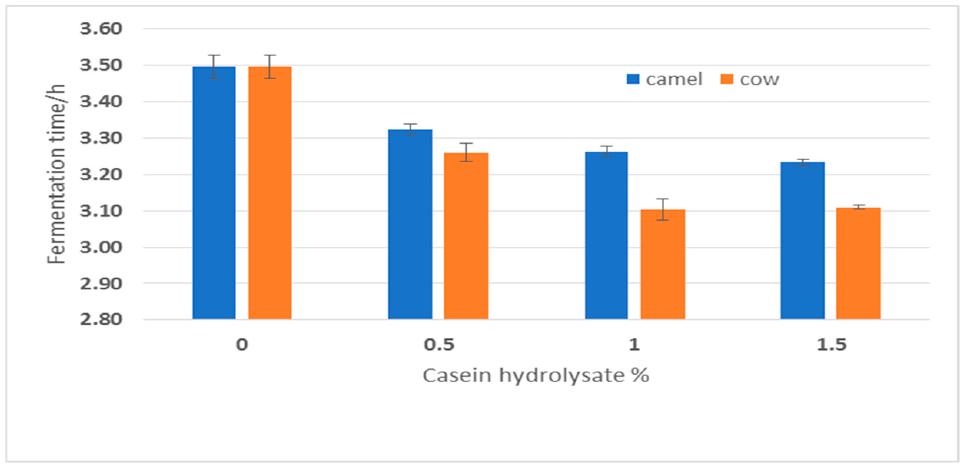
Figure 3. Fermentation times of yogurt with added casein hydrolysates.